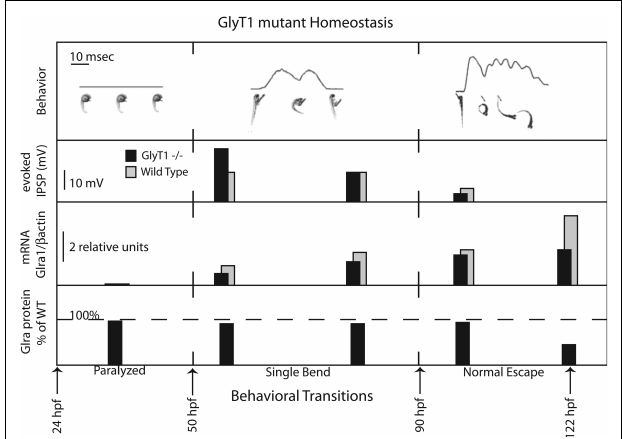
FIGURE 2 | GlyT1 mutant neuronal homeostasis. Top Row: GlyT1 mutants exhibit two behavioral transitions, from paralysis to a single bend at 50-h post fertilization and from single bend to full recovery at 90-h post fertilization. Line graphs are produced by motion detection software that tracks larval pixel displacement over time. Below line graphs till images of the embryos and larvae are placed at corresponding timepoints. Second row: Maximum amplitude in millivolts (mV) of evoked motor neuron glycinergic inhibitory post-synaptic potentials (IPSPs) recorded in GlyT1 mutants versus wild type larvae at three timepoints. Third Row: Relative quantitation of mRNA expression, a1 subunit of the glycine receptor (Glra1) normalized to bactin, using quantitative polymerase chain reaction to compare GlyT1 mutants versus wild type. Fourth Row: Comparison (% of wild type staining) of maximum antibody labeling of motor neuron glycine receptor alpha subunits in GlyT1